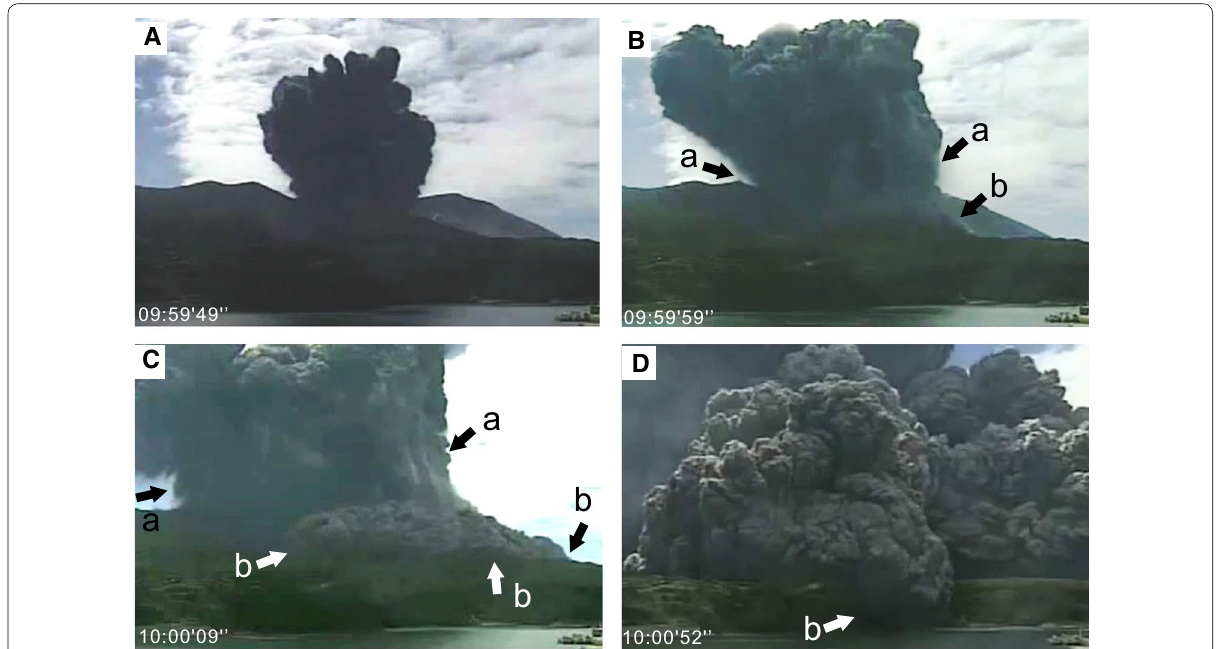
Fig. 2 Snapshots of the PDC from the monitoring camera located 3 km NW of Shindake operated by Japan Meteorological Agency ( A – D ). Location of the camera is shown in Fig. 1. A 10 s after the onset of the eruption (9:59 ′ 49 ″ ). Pyroclastic materials ejected as jet and form rising eruption column. B 20 s after the onset of the eruption (9:59 ′ 59 ″ ). A part of the eruption column is collapsing (a). The front of the PDC can be recognized at the foot of the eruption column (b). C 30 s after the onset of the eruption (10:00 ′ 09 ″ ). The migrating front of PDC is indicated by arrows (b). D 75 s after the onset of the eruption (10:00 ′ 52 ″ ). The front of PDC (b) reached the beach of